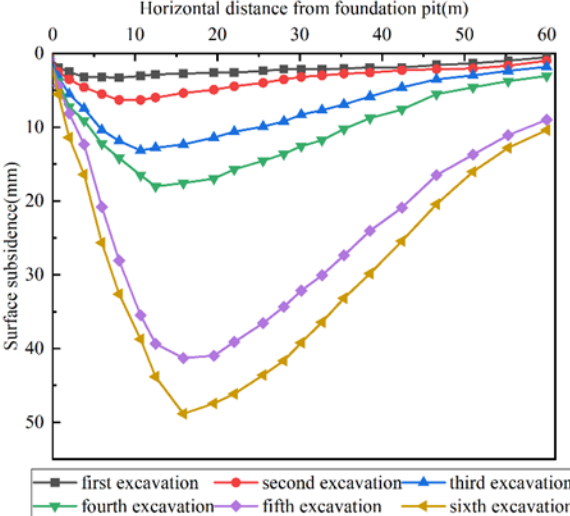
Figure 23. Surface settlement curve during foundation pit excavation with a 0.01 m-wide seepage point.